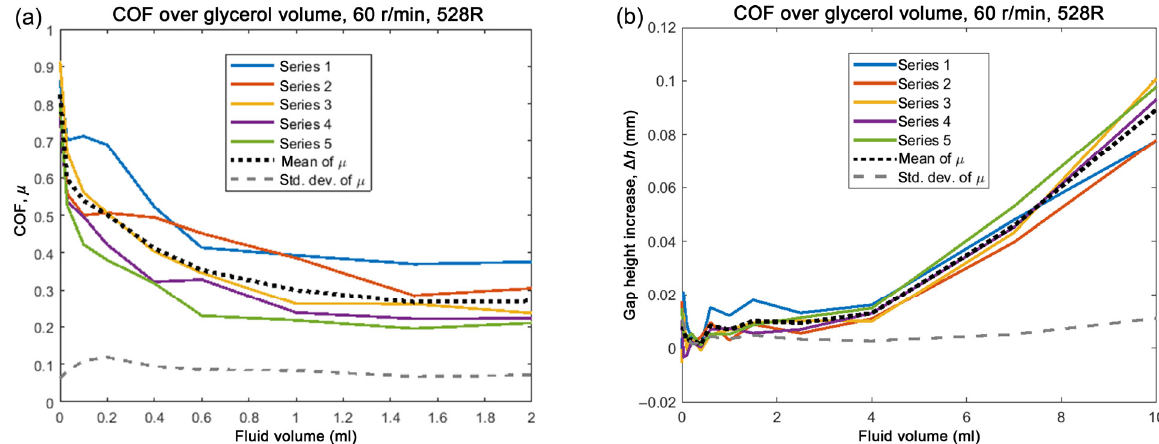
Fig. 16 Results with macroscopic glass surfaces: (a) COFs for varying fluid volumes (1 mL corresponds to approximately 10% filling ratio), (b) gap height increases (GHIs) due to supplied fluid volumes. Reproduced with permission from Ref. [13], © the authors